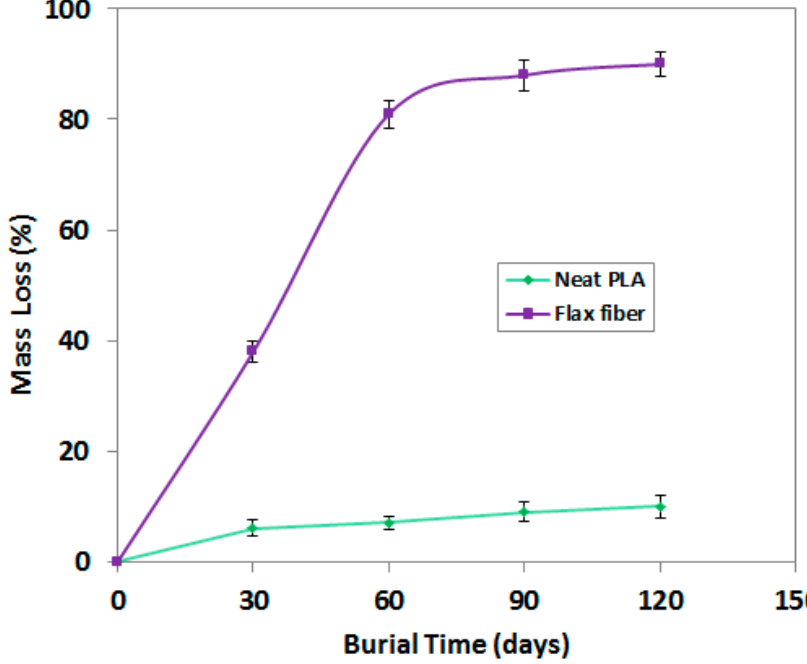
Figure 9. Effect of biodegradations on PLA and flax fibers.